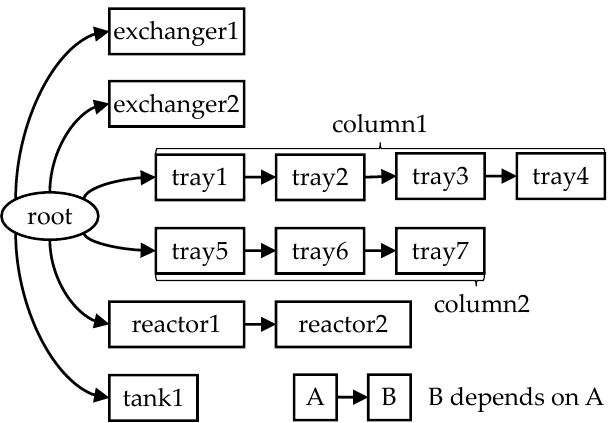
Figure 7. Sketch of DAG allocation.